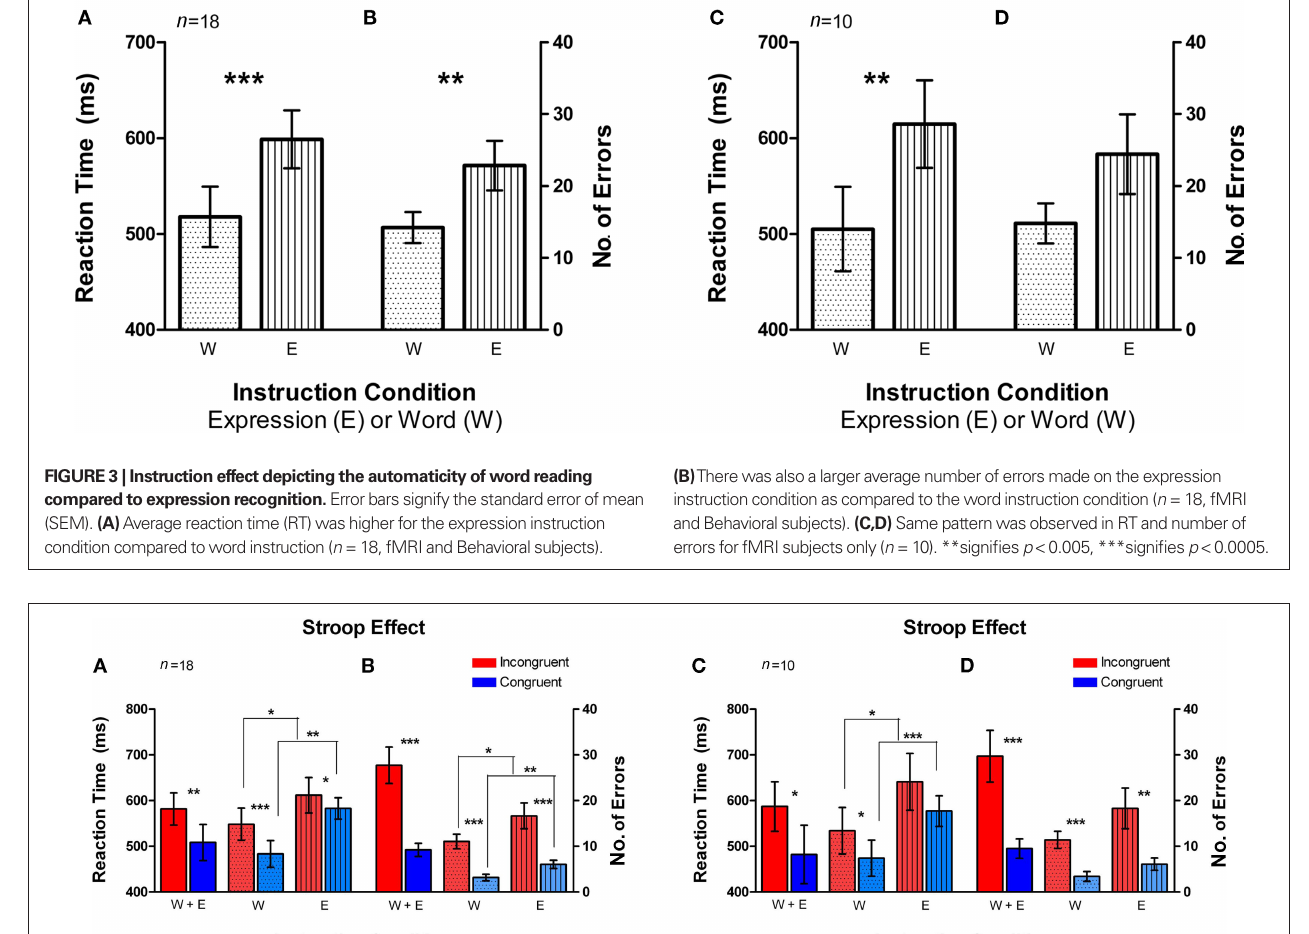
FIguRe 4 | Classic Stroop effect in the emotional Stroop task. Incongruent trials (red bars) had an overall higher average RT and errors as compared to the congruent trials (blue bars). Error bars signify the standard error of mean (SEM). (A) Average reaction time (RT) plotted on the left axis for different instruction conditions ( n = 18,